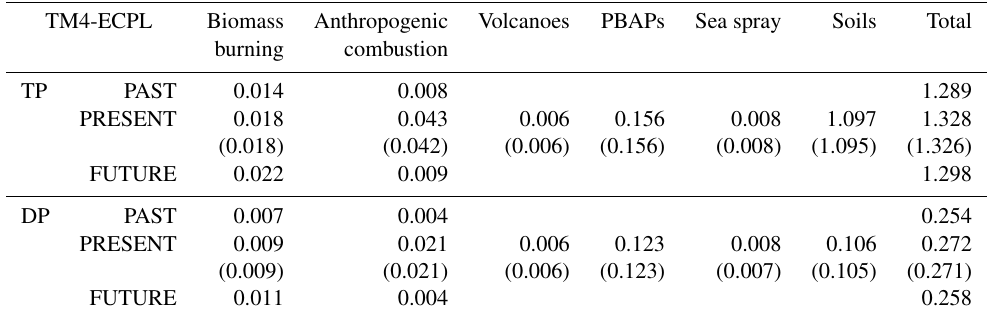
Table 1. Emissions of TP and DP (inTg-Pyr − 1 ) taken into account in the TM4-ECPL model for PAST, PRESENT and FUTURE simulations. In parenthesis, the average values of TP and DP emissions for the years 2000–2010 are also